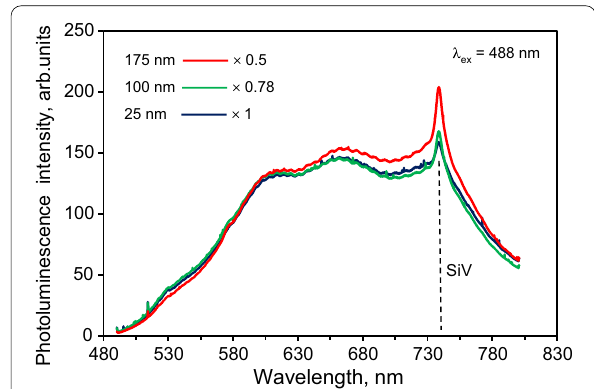
Fig. 8 PL spectra of various submicron fractions of Microdiamant ™ polycrystalline diamond particles: blue—DP 0–0.05 (mean size 25 nm), green—DP 0–0.2 (mean size 100 nm), red—DP 0–0.35 (mean size 175 nm). Excitation wavelength λ 488 nm. The prominent peak = at 738 nm marked by the vertical dashed line is the zero-phonon line of negatively charged SiV − centres, which can be observed in all polycrystalline diamond fractions. For better comparison, the spectra are specially normalized for PL intensity at λ 590 nm. Normalising = coefficients are indicated in the